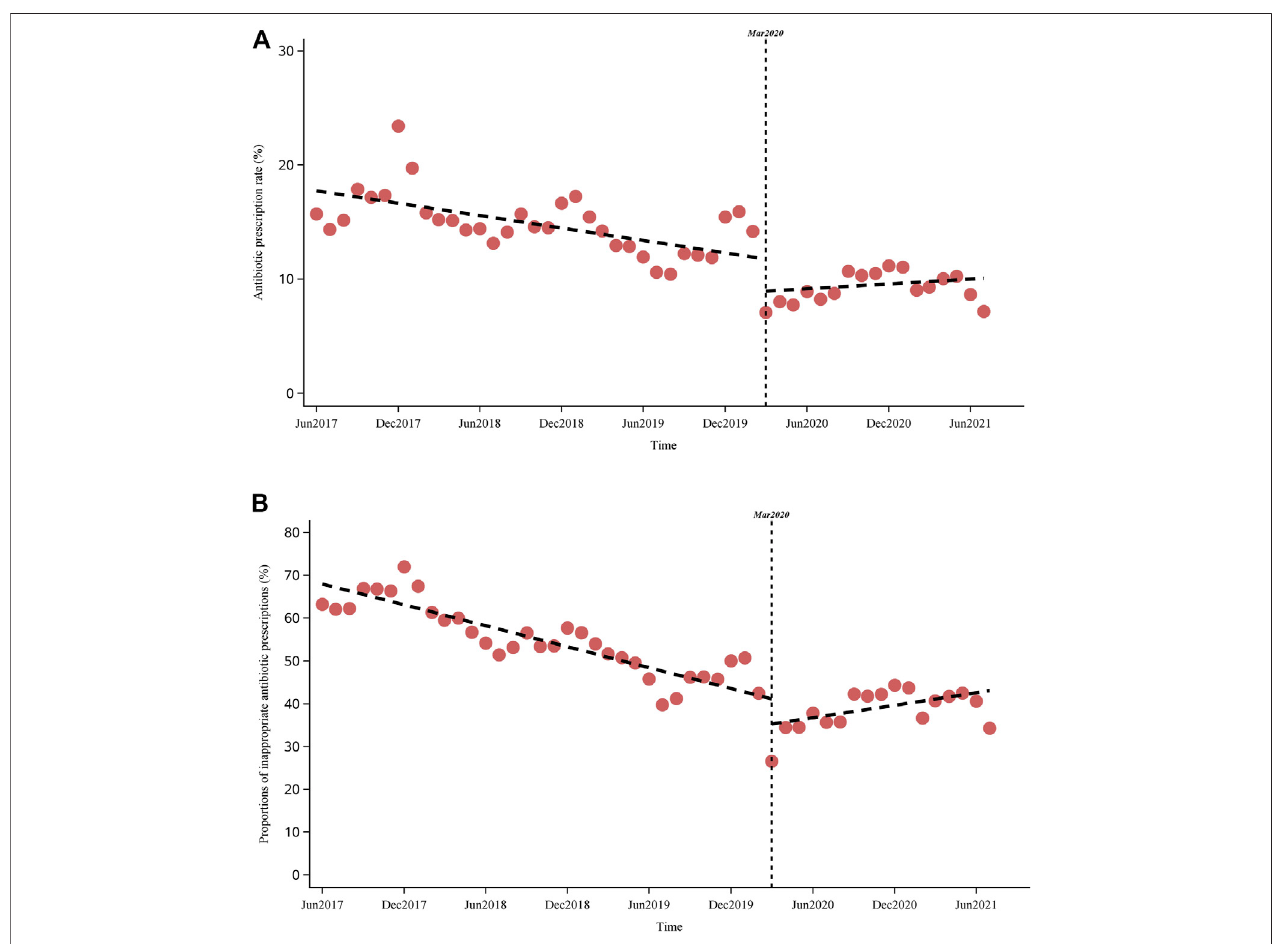
FIGURE 4 | Impact of COVID-19 on the antibiotic prescription rate and inappropriate antibiotic prescriptions. ( A) (above): Impact of COVID-19 on antibiotic prescription rate. ( B) (below): Impact of COVID-19 on inappropriate antibiotic prescriptions.